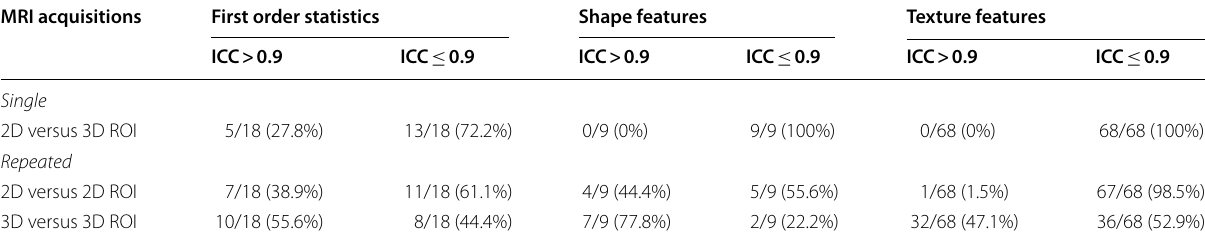
Table 2 Radiomics feature